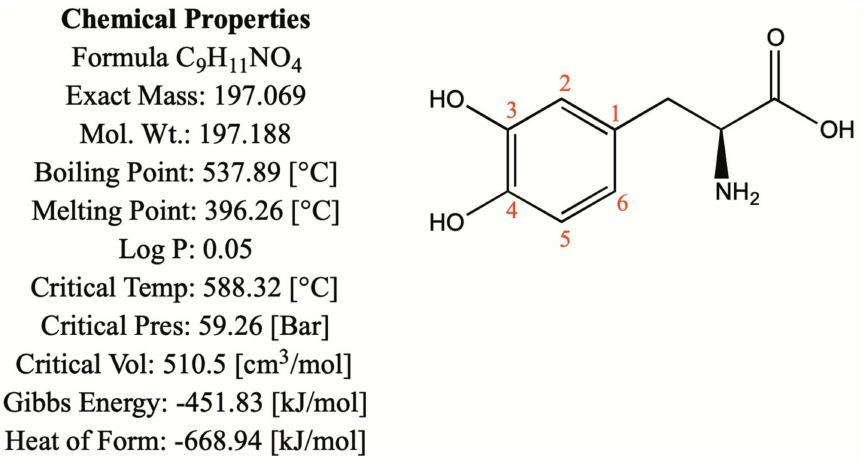
Figure 1. L-Dopa, (3,4-dihydroxyphenyl)-L-alanine, structure and its chemical and physical